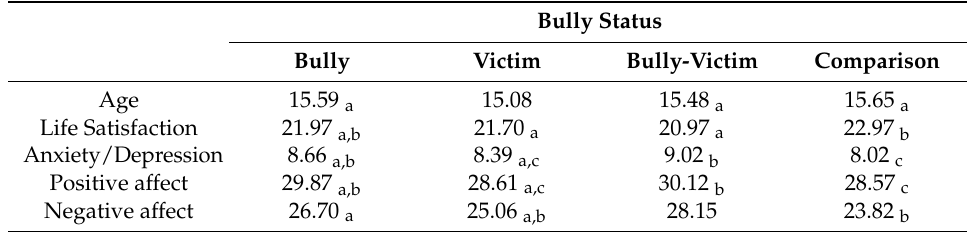
Table 3. Comparison of independent variables across bully/victim groups.